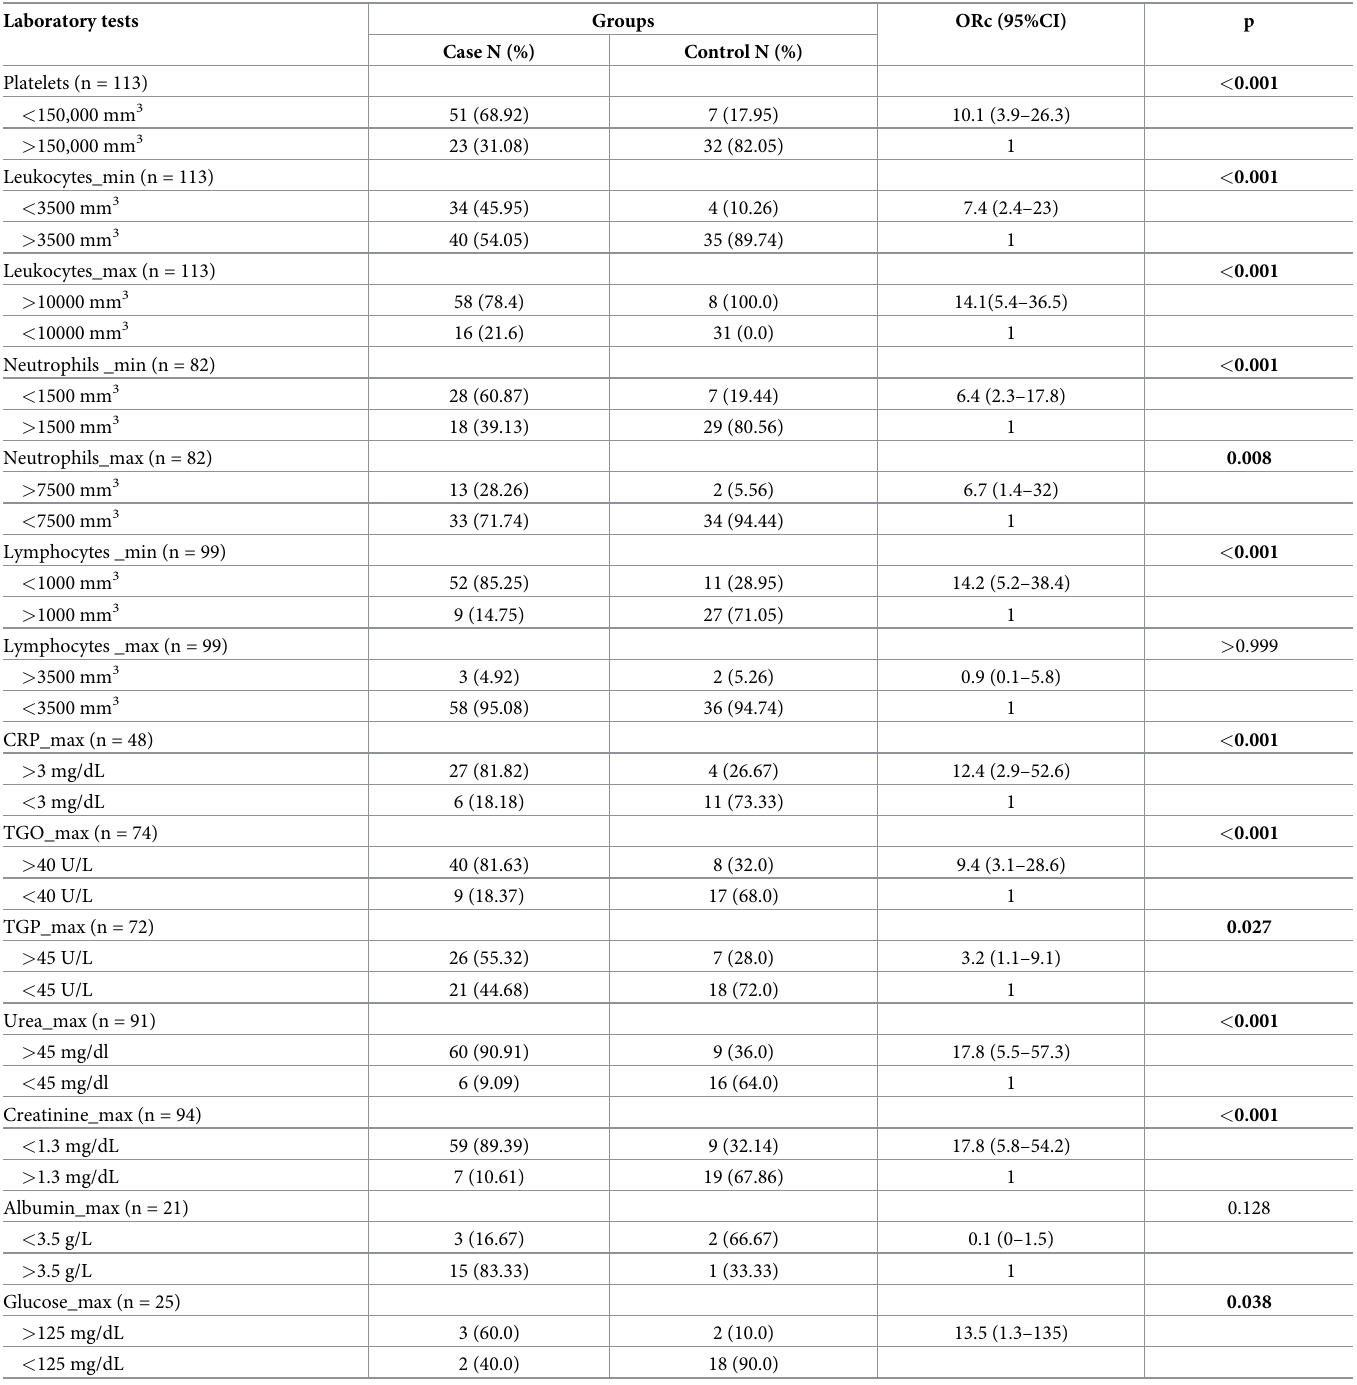
Table 4. Laboratory tests of cases (deaths) and controls